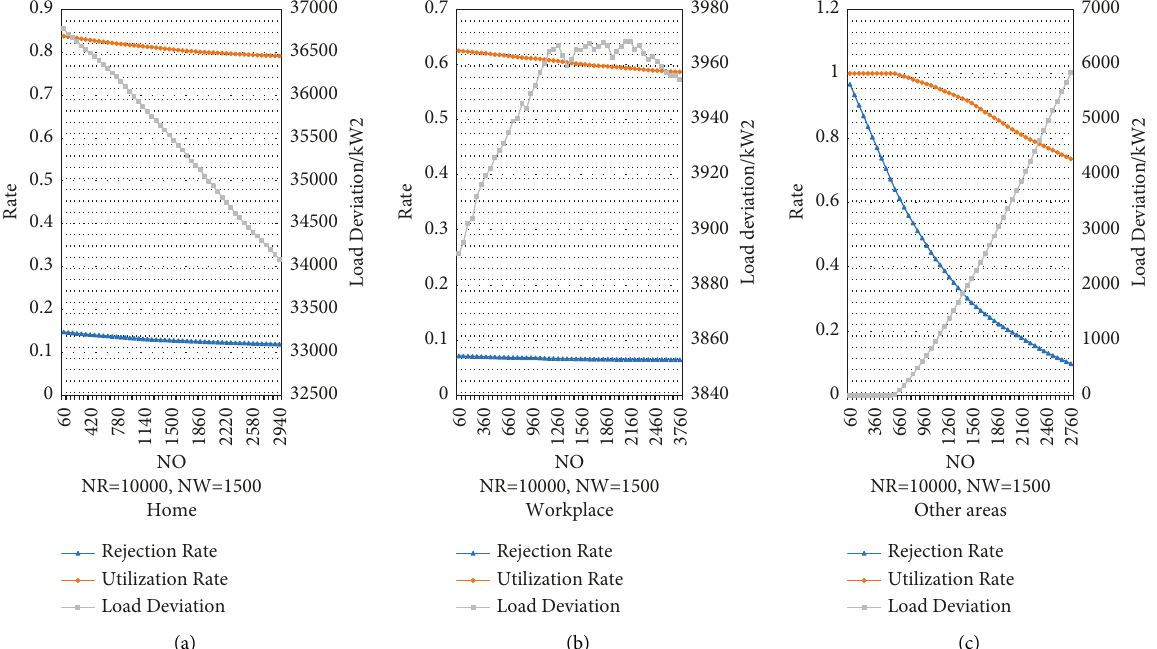
Figure 7: Influence of the number of charging piles in other areas (NO) on operational efficiency. (a) Home. (b) Workplace. (c) Other